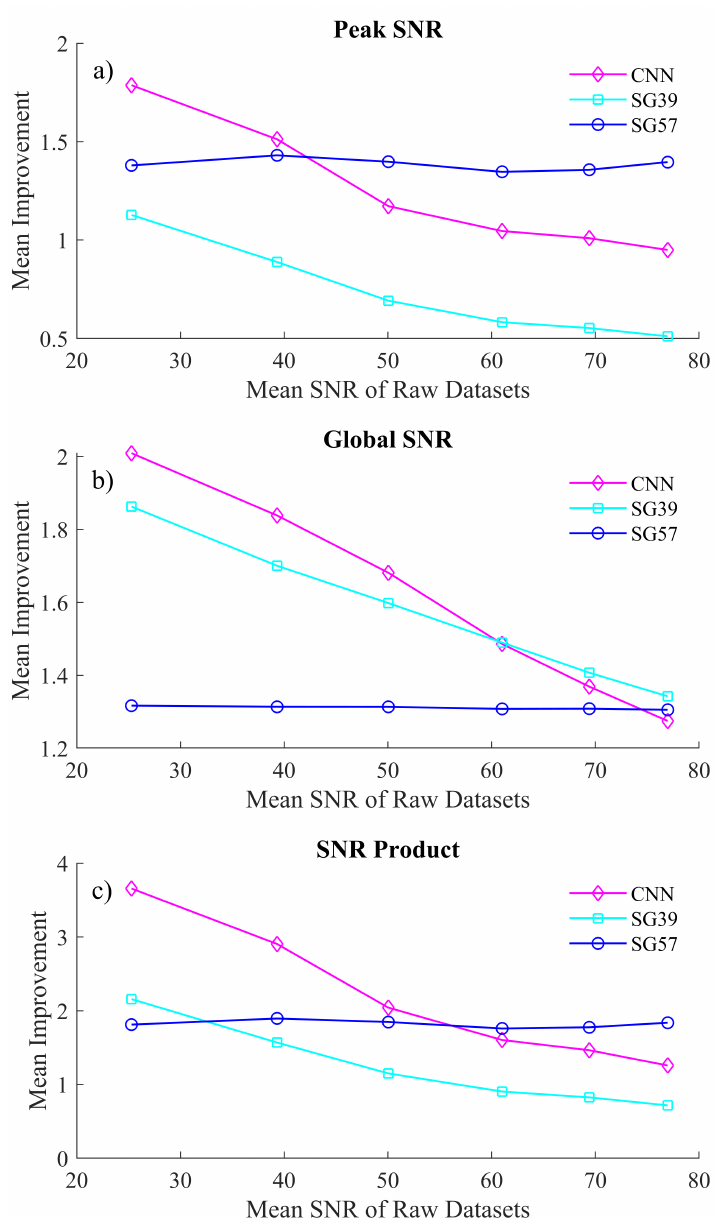
Figure 4. A comparison of the mean improvement in ( a ) global SNR, ( b ) peak SNR and ( c ) the SNR product from the the proposed CNN denoising algorithm and the competing SG filters. The x -axis is labeled in terms of the mean SNR of the raw datasets collected under the experimental conditions detailed in Section